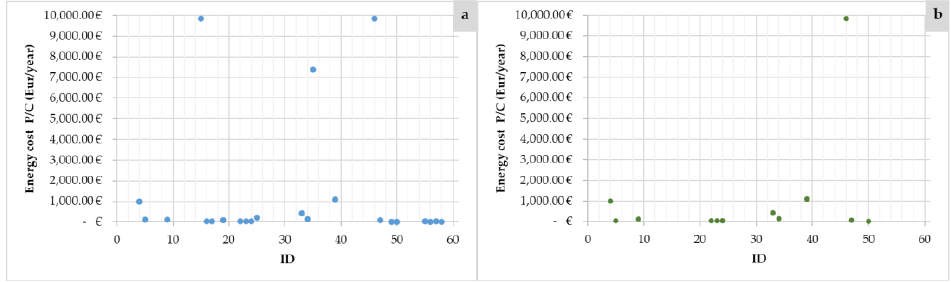
Figure 9. Energy cost related to water usage per capita or per Ha for OS ( a ) and MS ( b ).